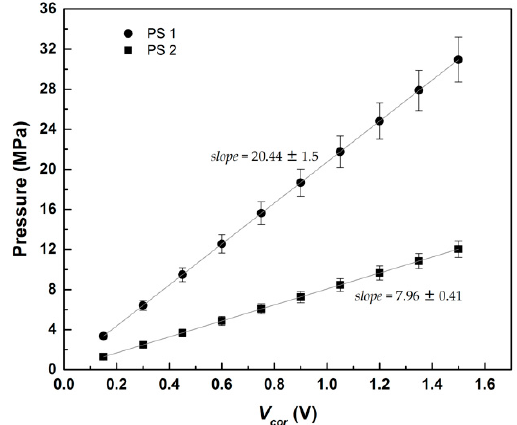
Figure 5. Calibration curves for PS 1 and PS 2, fitted with a linear function.